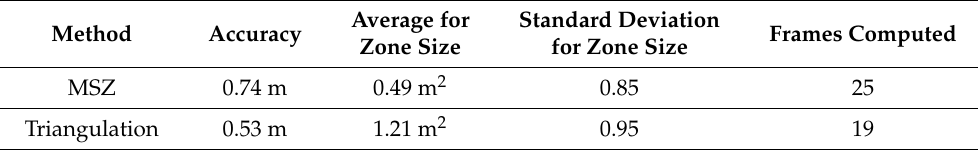
Table 4. Accuracy values for MZS algorithm and triangulation applied to DS1 . Method